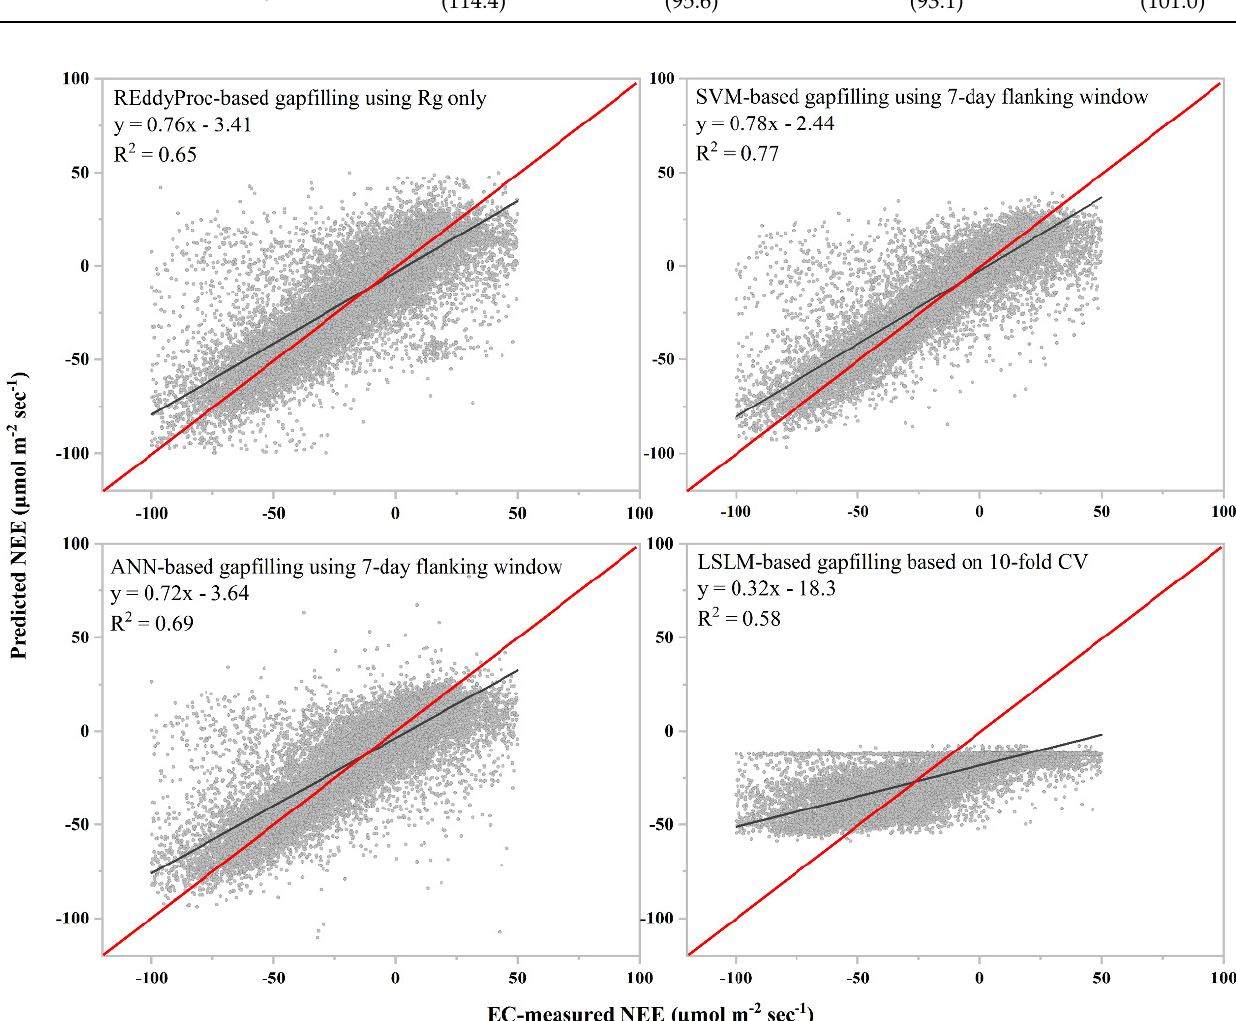
Figure 8. Benchmarking results of filling artificial gaps of the net ecosystem exchange (NEE) data based on the optimal prediction models and cross-validation settings. Regressions of predicted NEE by the REddyProc software using just global radiation alone ( top-left ), support vector machine (SVM, top-right ) and artificial neural network (ANN, bottom-left ) using 7-day window training data flanking each missing/testing value, and the least-square linear model (LSLM) based on a 10-fold cross validation (10-fold CV, bottom-right ); against the eddy-covariance (EC) measured NEE values are presented. The red line indicated 1:1 perfect prediction line.